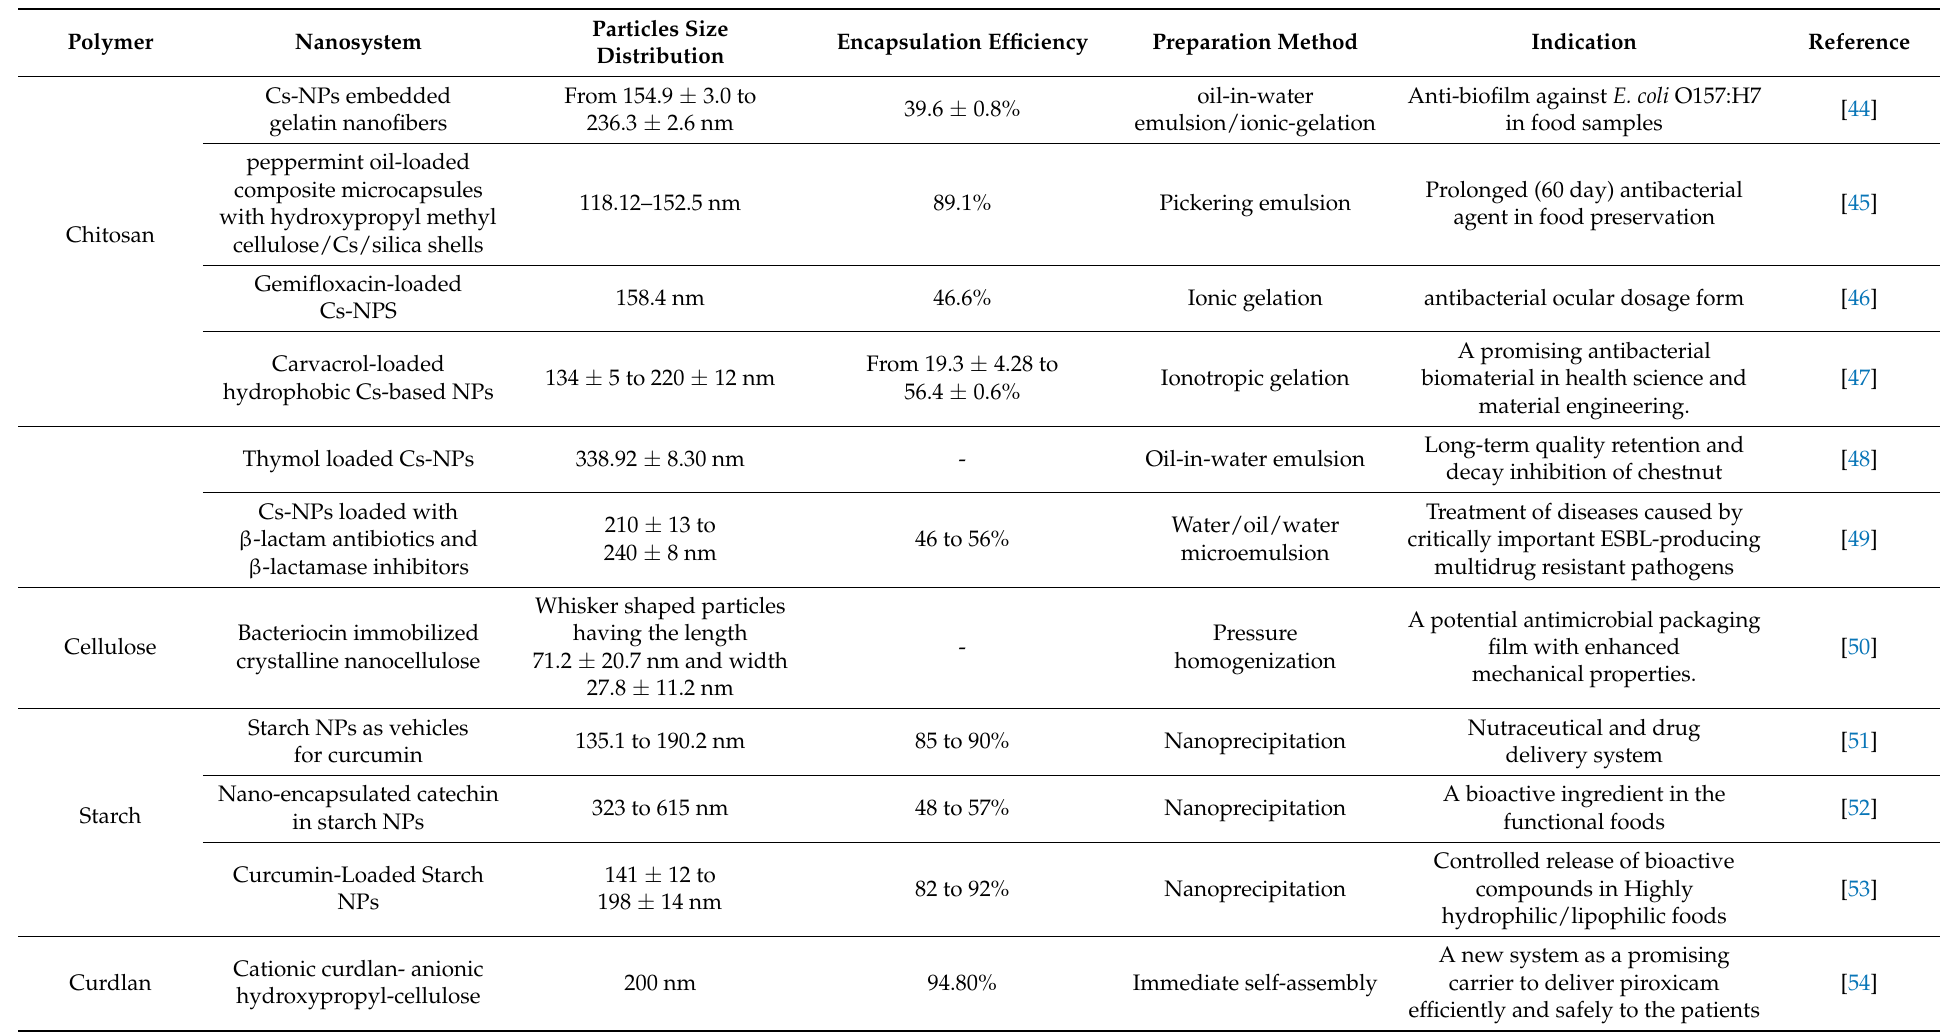
Table 1. Physichochemical properties of recently investigated bio based PNPs and their